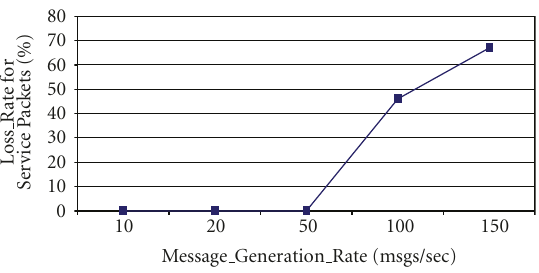
Figure 12: Service Packets-Loss Rate versus Messages Generation Rate (mean message size = 500bytes and mean number of neighbors = 50).